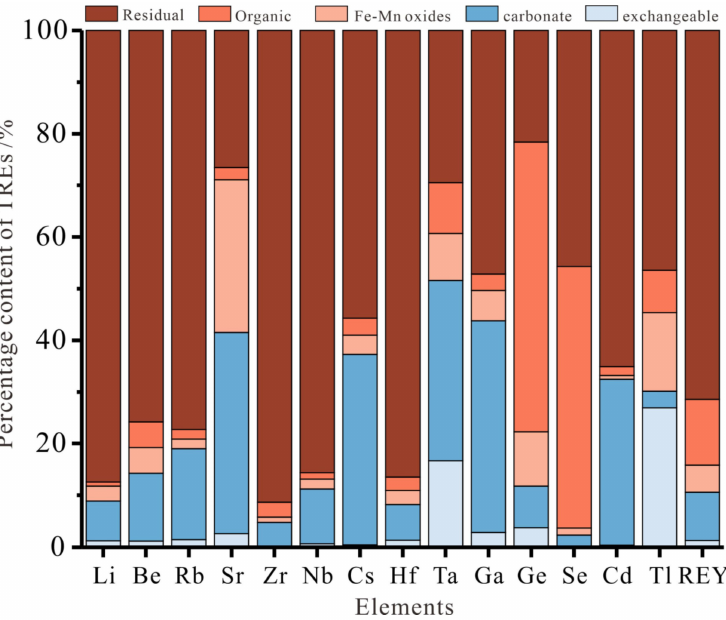
Figure 6. Experimental results of sequential chemical extraction of